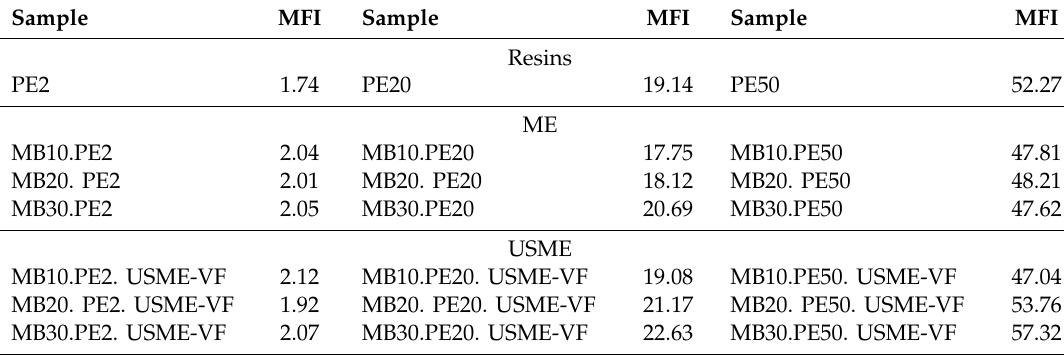
Table 3. Melt flow index for polymers and masterbatches, evaluated at 220 ◦ C / 2.16